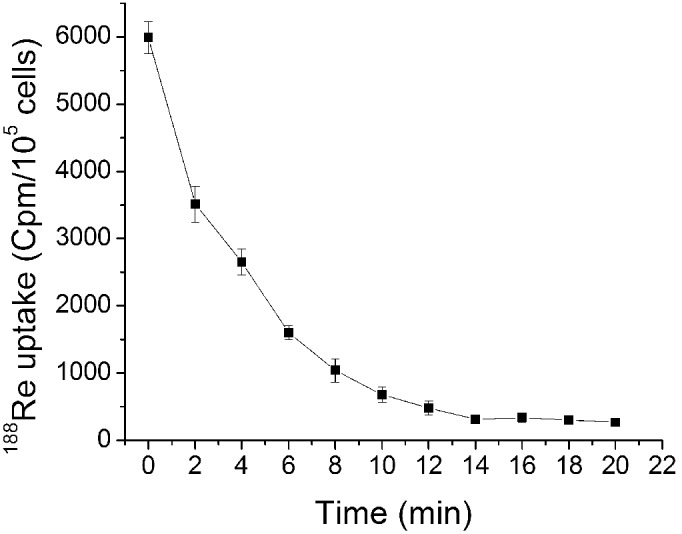
Time dependent 188Re efflux assay in U87-hNIS cells after a 20 minute incubation with 3.7 kBq 188Re in 0.5 mL bHBSS.Results are expressed as counts per minute for 105 cells. Data points are means ± SD (n = 3).